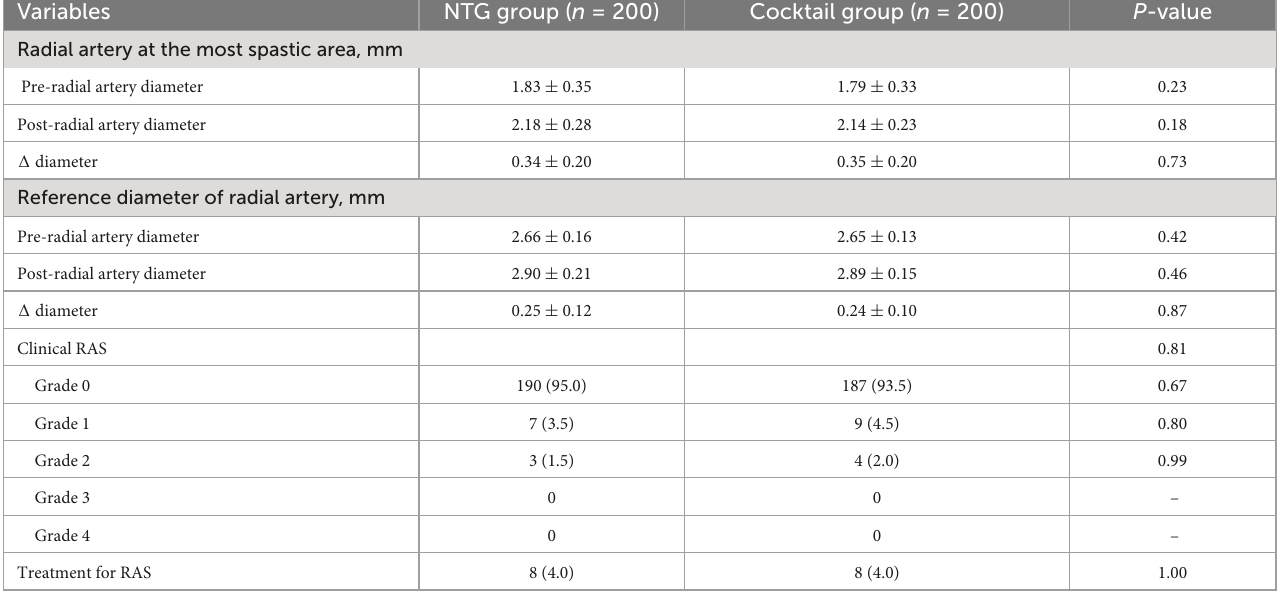
TABLE 3 Efficacy